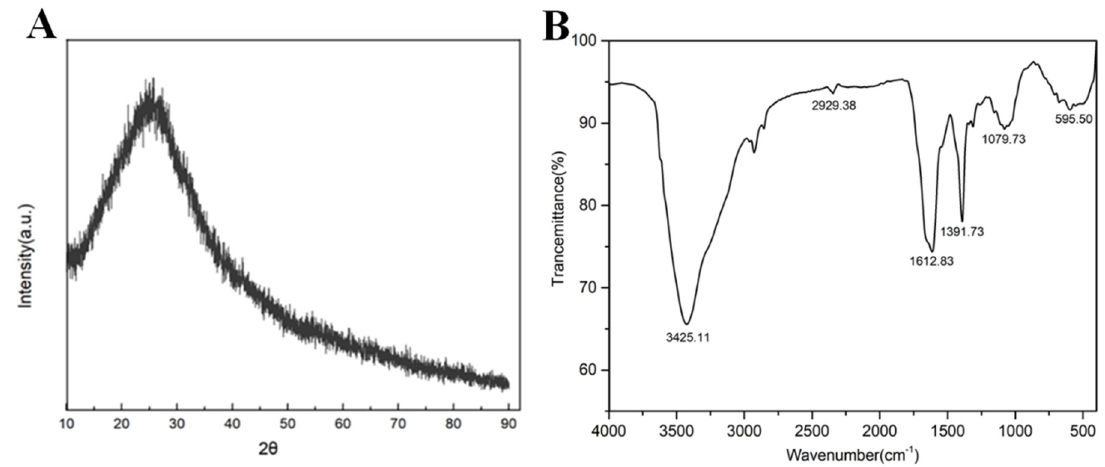
Figure 3. XRD ( A ) and FT ‐ IR spectra of R ‐ CDs ( B ).